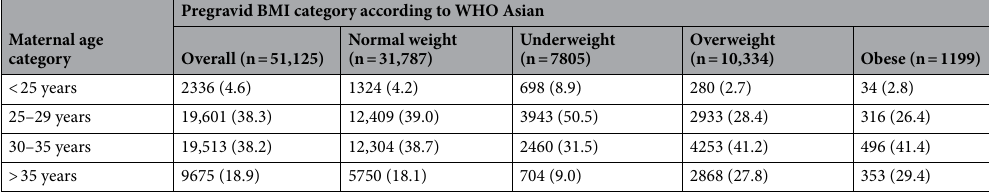
Table 2. Pregravid BMI characteristics of the study participants.